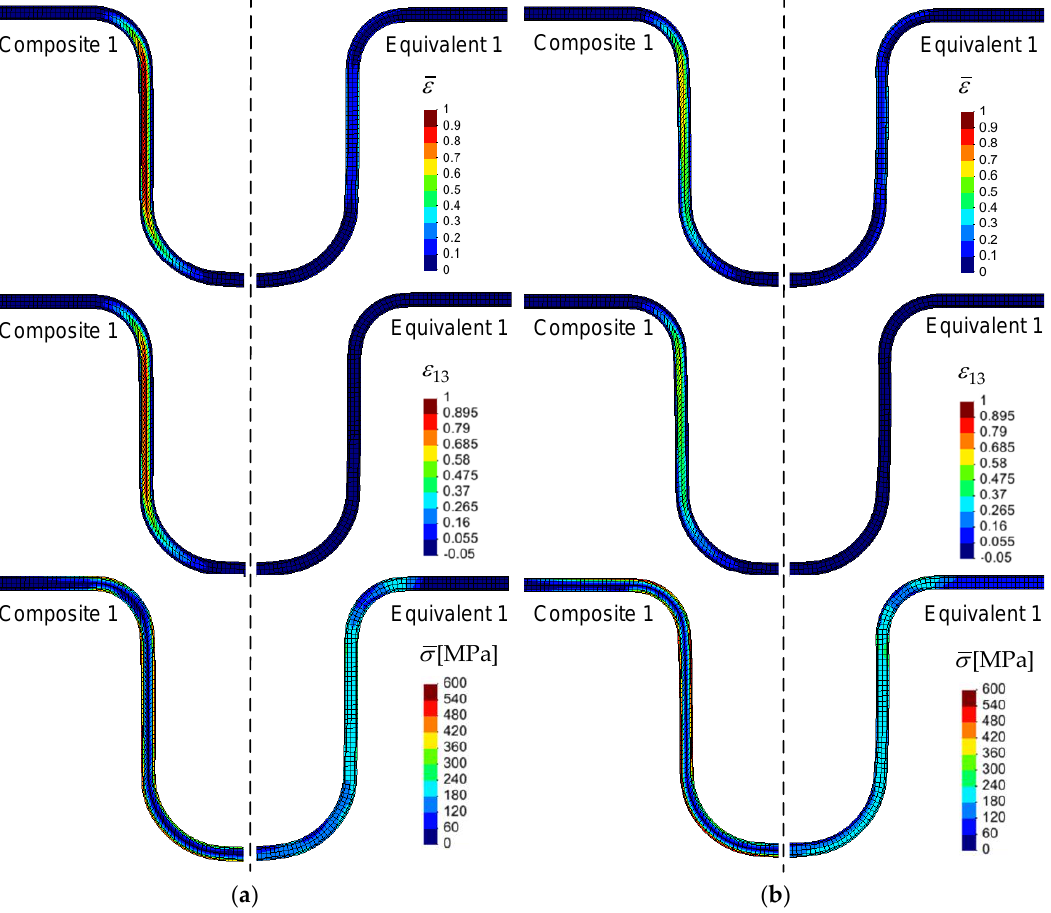
Figure 11. Distributions of equivalent plastic strain, 𝜀̅ , Green–Lagrange shear strain, 𝜀 13 , and equivalent stress, 𝜎 , for Composite 1 and the equivalent material: ( a ) Case A; ( b ) Case B. The maximum values of 𝜀̅ , 𝜀 13 and 𝜎̅ are, respectively: 0.976, 0.978 and 515.75 MPa (for Composite 1 in Case A); 0.717, 0.619 and 578.23 MPa (for Composite 1 in Case B); 0.340, 0.007 and 267.71 MPa (for Equivalent 1 in Case A); 0.327, 0.007 and 263.5 MPa (for Equivalent 1 in Case B).